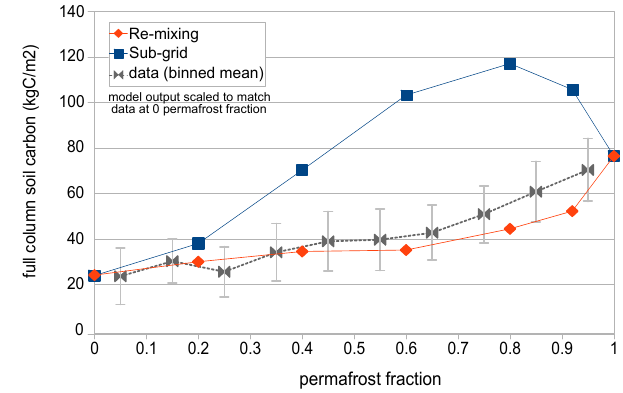
Figure 6. Modelled output for 1-D models along a permafrost gra- dient, with correction for NPP and initial value (at 0% permafrost). Overlaid on 1 ◦ data for SOCC binned into 0.1 permafrost fraction mean values ± 1 sigma (Hugelius et al., 2013), permafrost fraction is calculated using relationship identified in Sect.